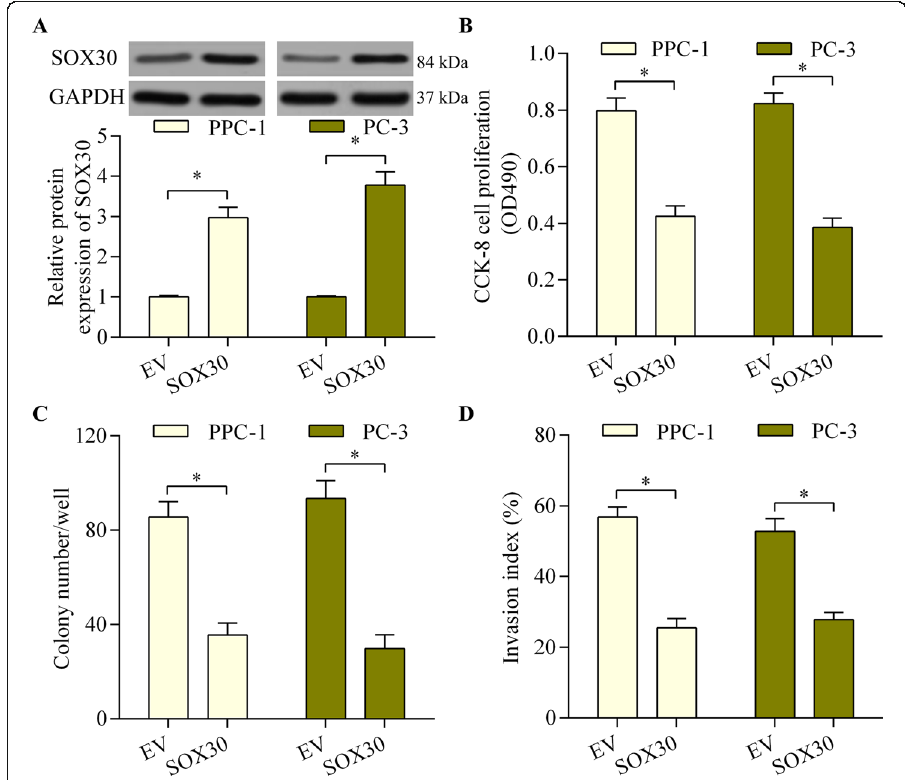
Fig. 2 SOX30 overexpression repressed prostate cancer cell proliferation and invasion. a PPC-1 and PC-3 cells were transfected with pcDNA3.1/SOX30 vector or empty vector (EV) for 48 h and SOX30 protein expression was examined via western blotting. b The effect of SOX30 overexpression on prostate cancer cell proliferation was determined with the CCK-8 assay after transection of cells with the pcDNA3.1/SOX30 vector for 48 h. c The effect of SOX30 overexpression on prostate cancer cell colony-forming ability was assessed with a colony formation assay. PPC-1 and PC-3 cells were transfected with pcDNA3.1/SOX30 vector for 48 h and then cultured for 14 days to form colonies. d The effect of SOX30 overexpression on prostate cancer cell invasive potential was evaluated using a transwell Matrigel invasion assay. PPC-1 and PC-3 cells were transfected with pcDNA3.1/SOX30 vector for 48 h. The transwell Matrigel invasion assay ran for 24 h. ( n = 5, * p <